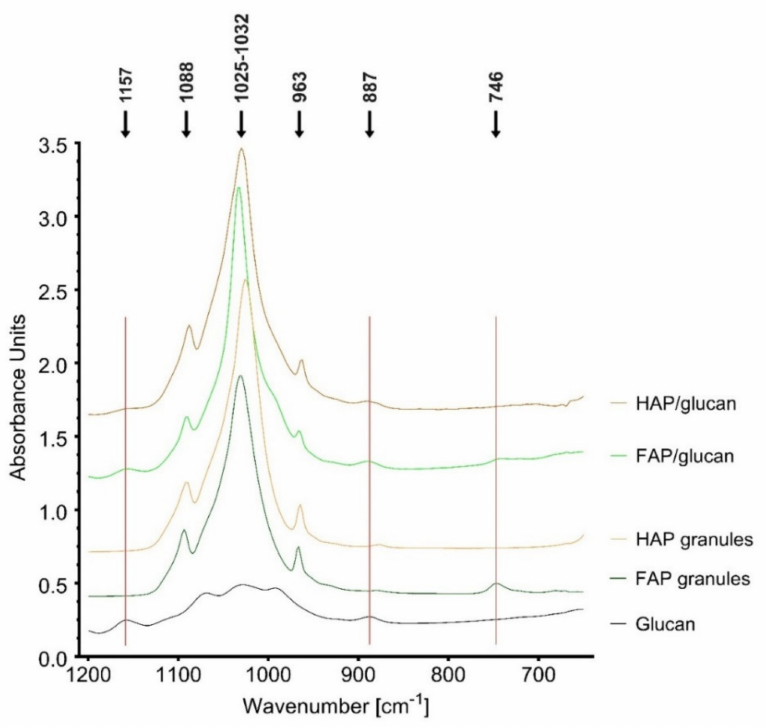
Figure 2. FTIR spectra of the composites, ceramic granules and polysaccharide